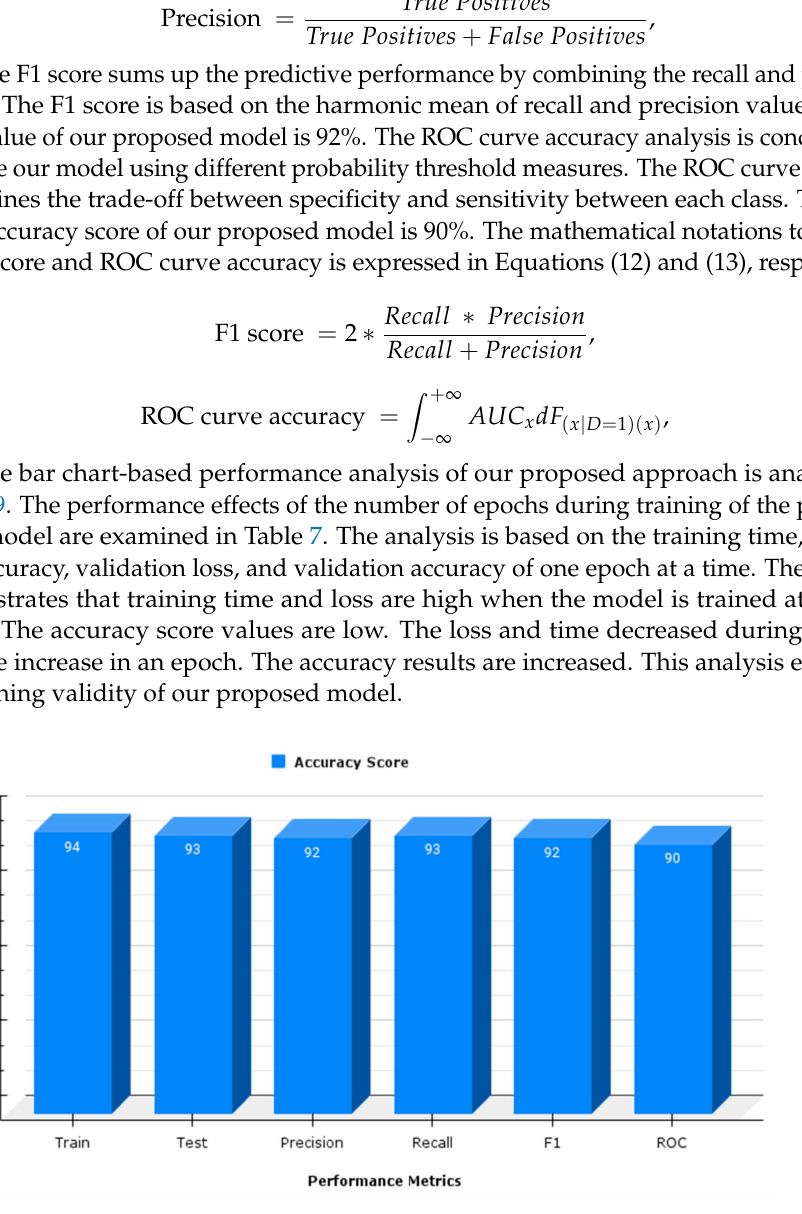
Figure 9. The metric performance analysis of our proposed BiGR